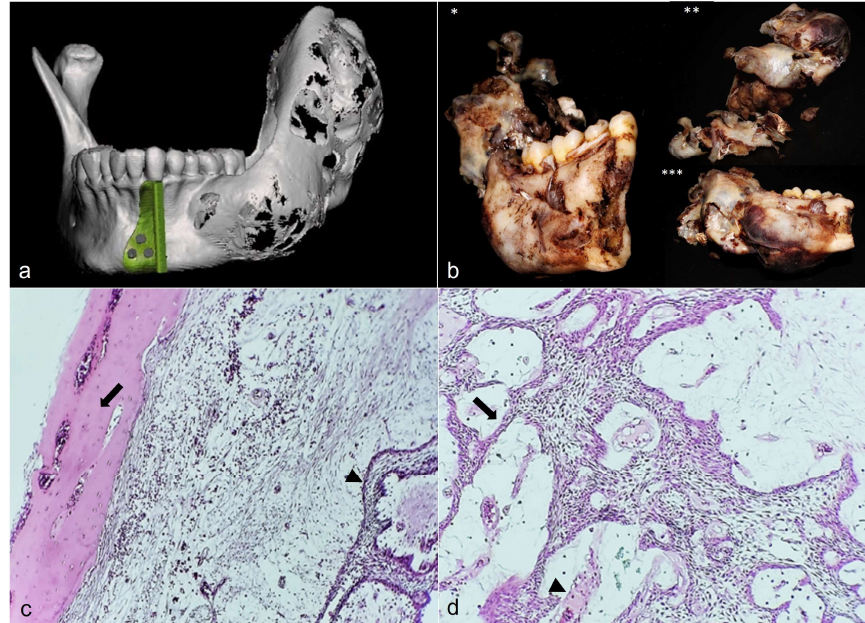
Figure 2. Tomographic surgical planning, specimen, and histopathological images. ( a )